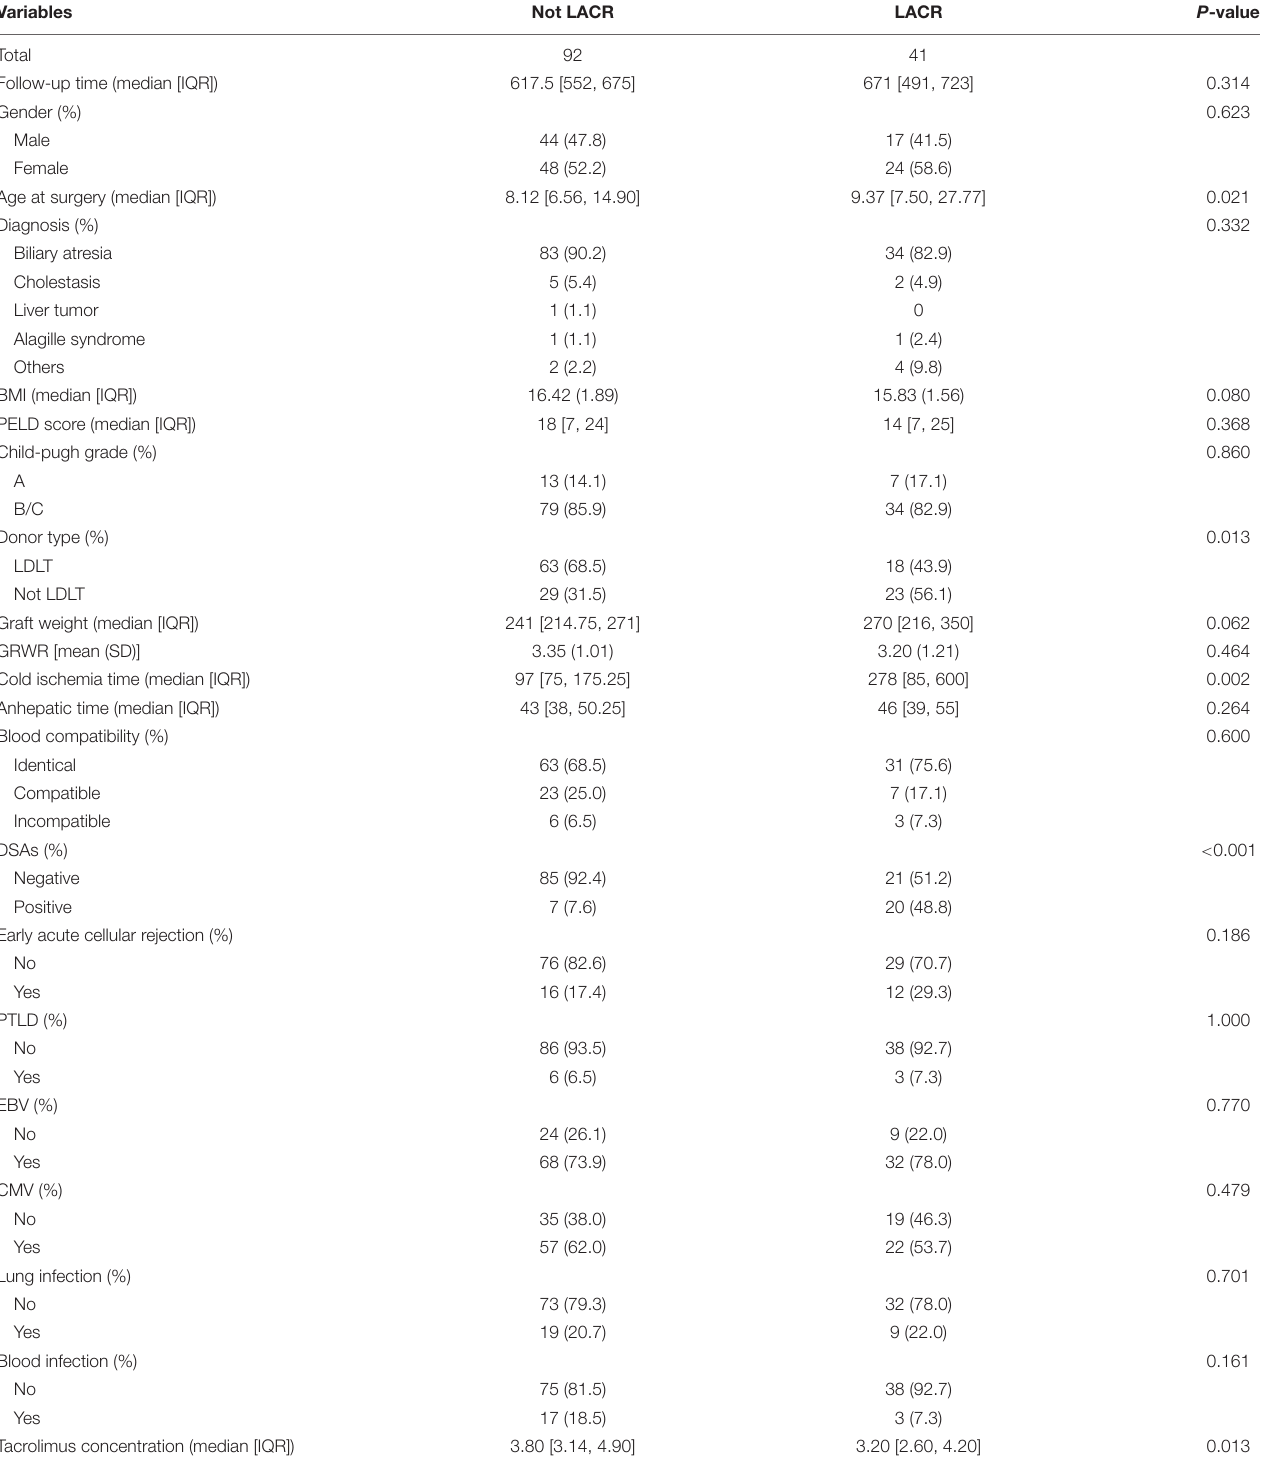
TABLE 1 | Clinical characteristics and univariable analysis of patients followed for > 1 ≤ 2 years. Variables Not LACR